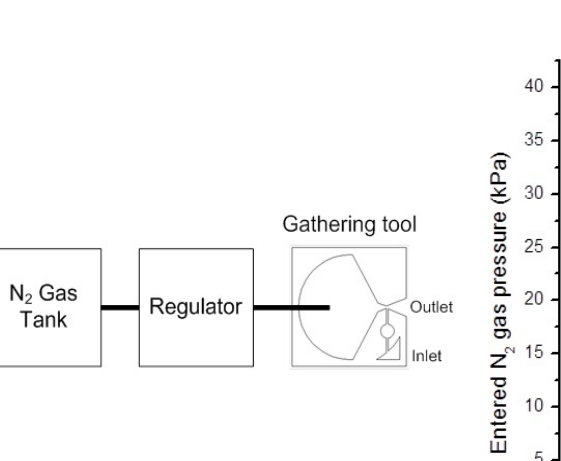
gas pressure measurement 2 gas pressure. 2